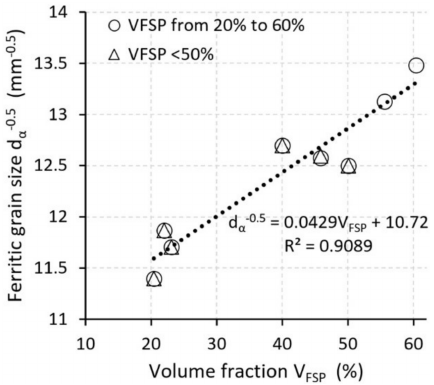
Figure 8. The dependence of the ferritic grain size on the volume fractions of the secondary phase.